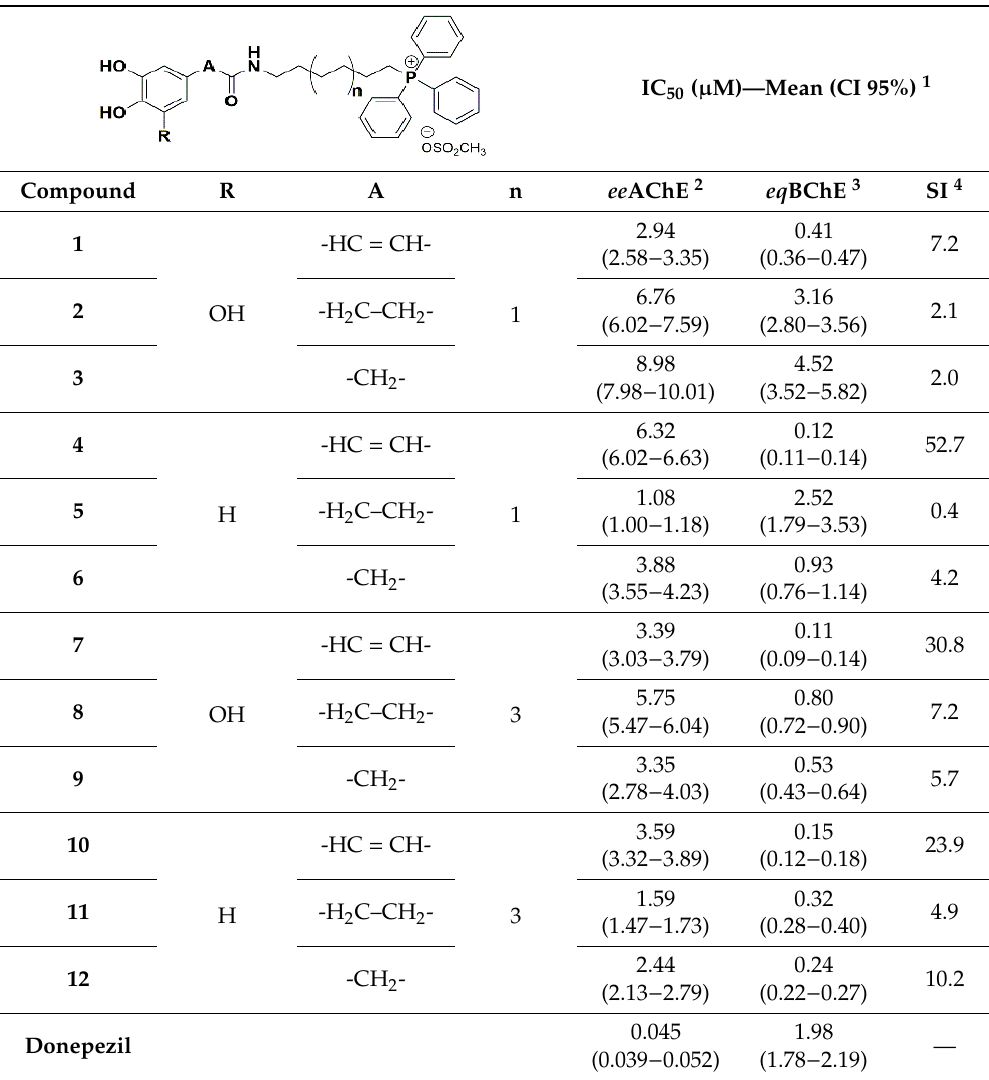
Table 1. Cholinesterases inhibitory activity (IC 50 ) data of the mitochondriotropic antioxidants and donepezil.